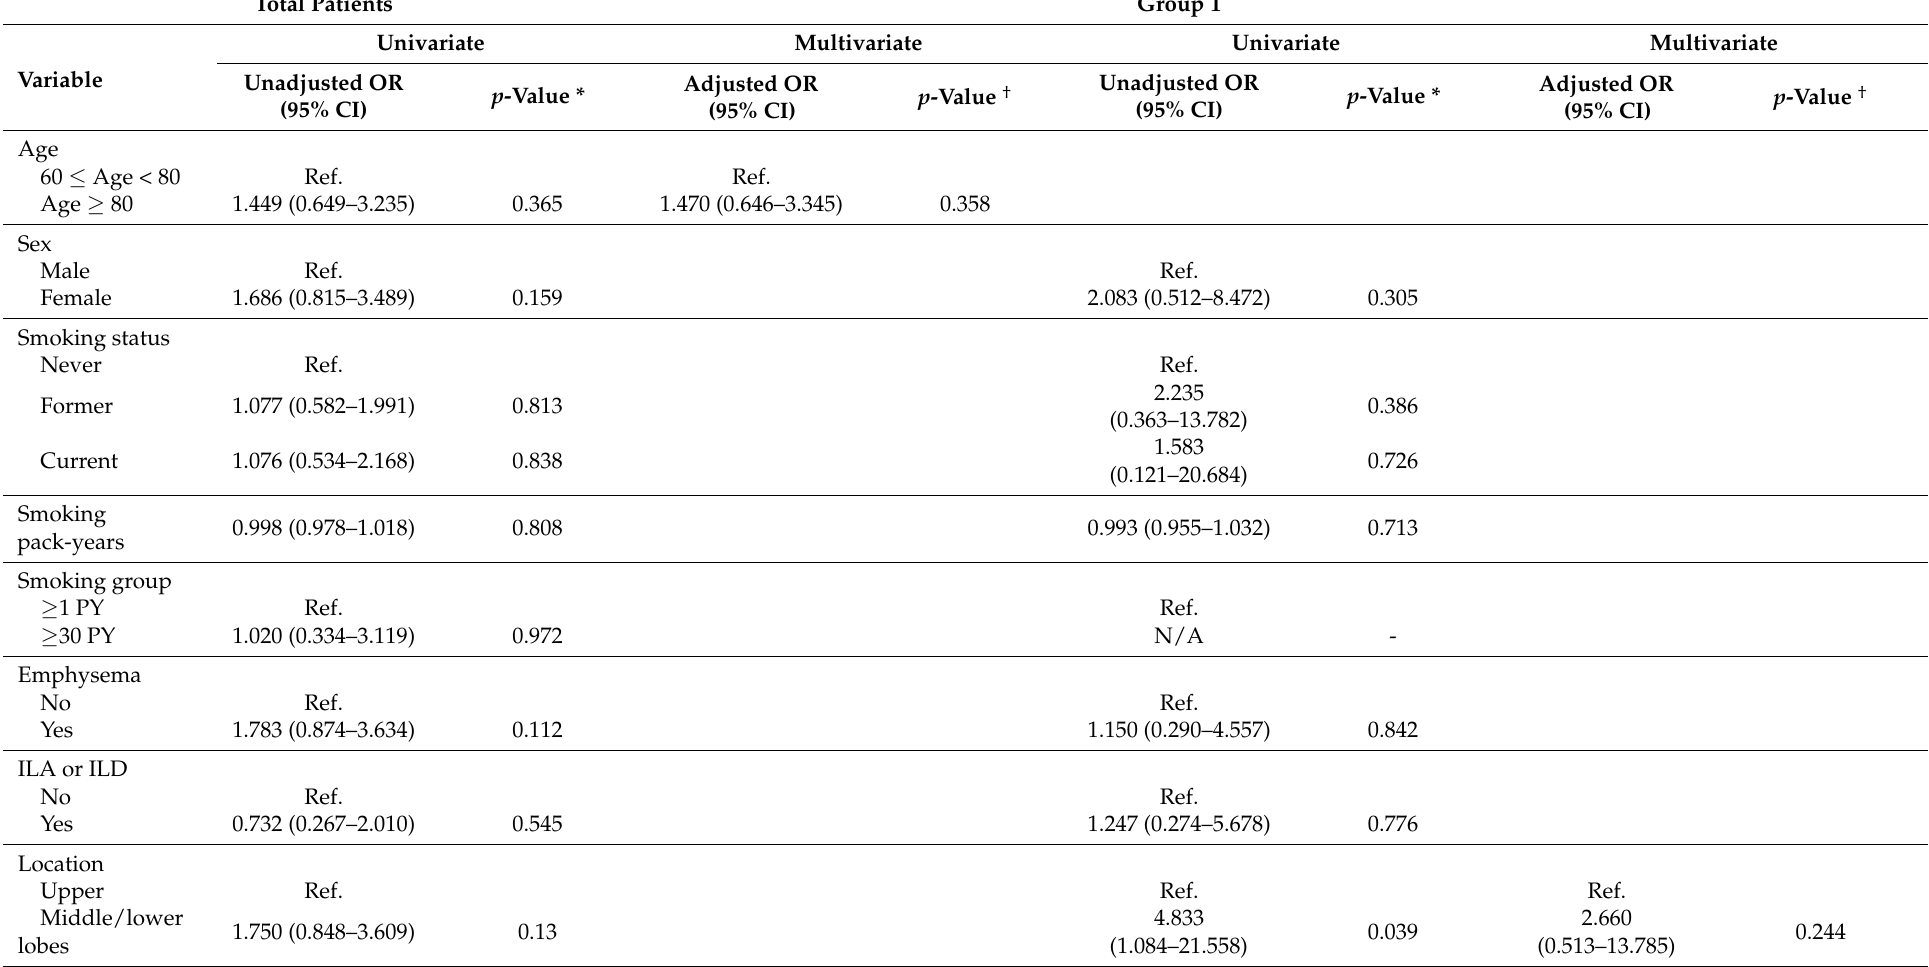
Table 5. Risk factors of diagnostic failure of CT-guided PTNB in total patients and Group 1